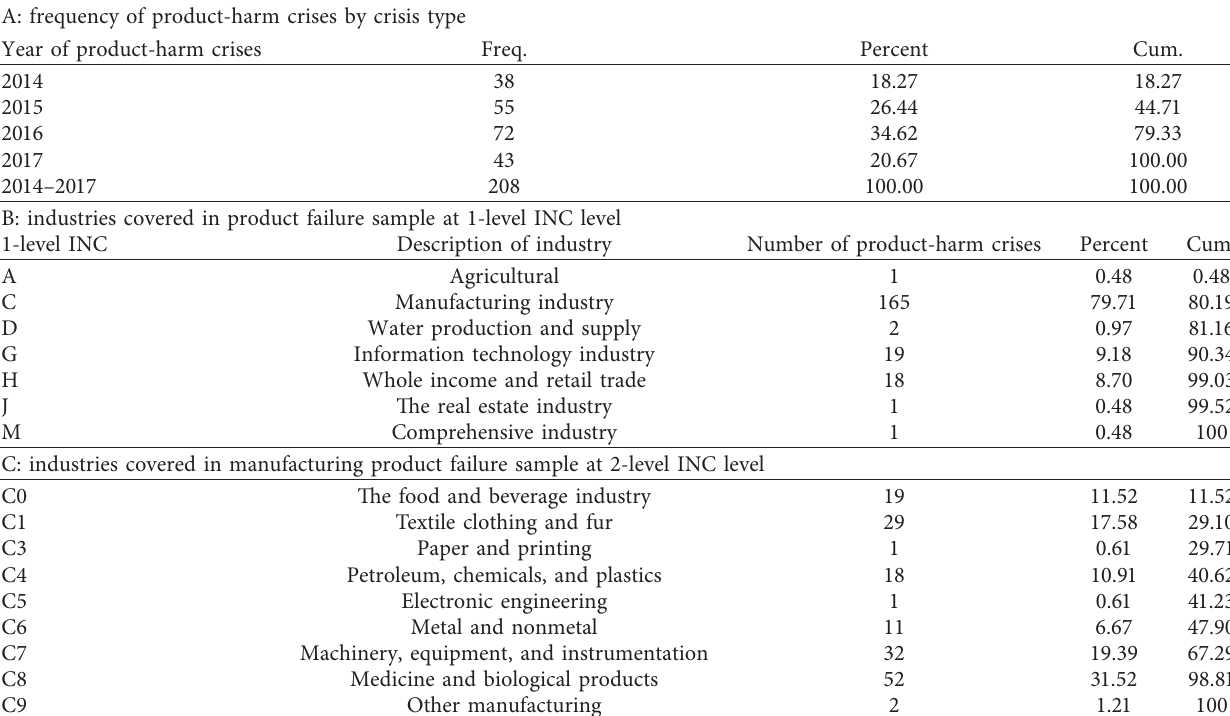
Table 1: Frequency of product-harm crises and industries covered in product-harm sample.